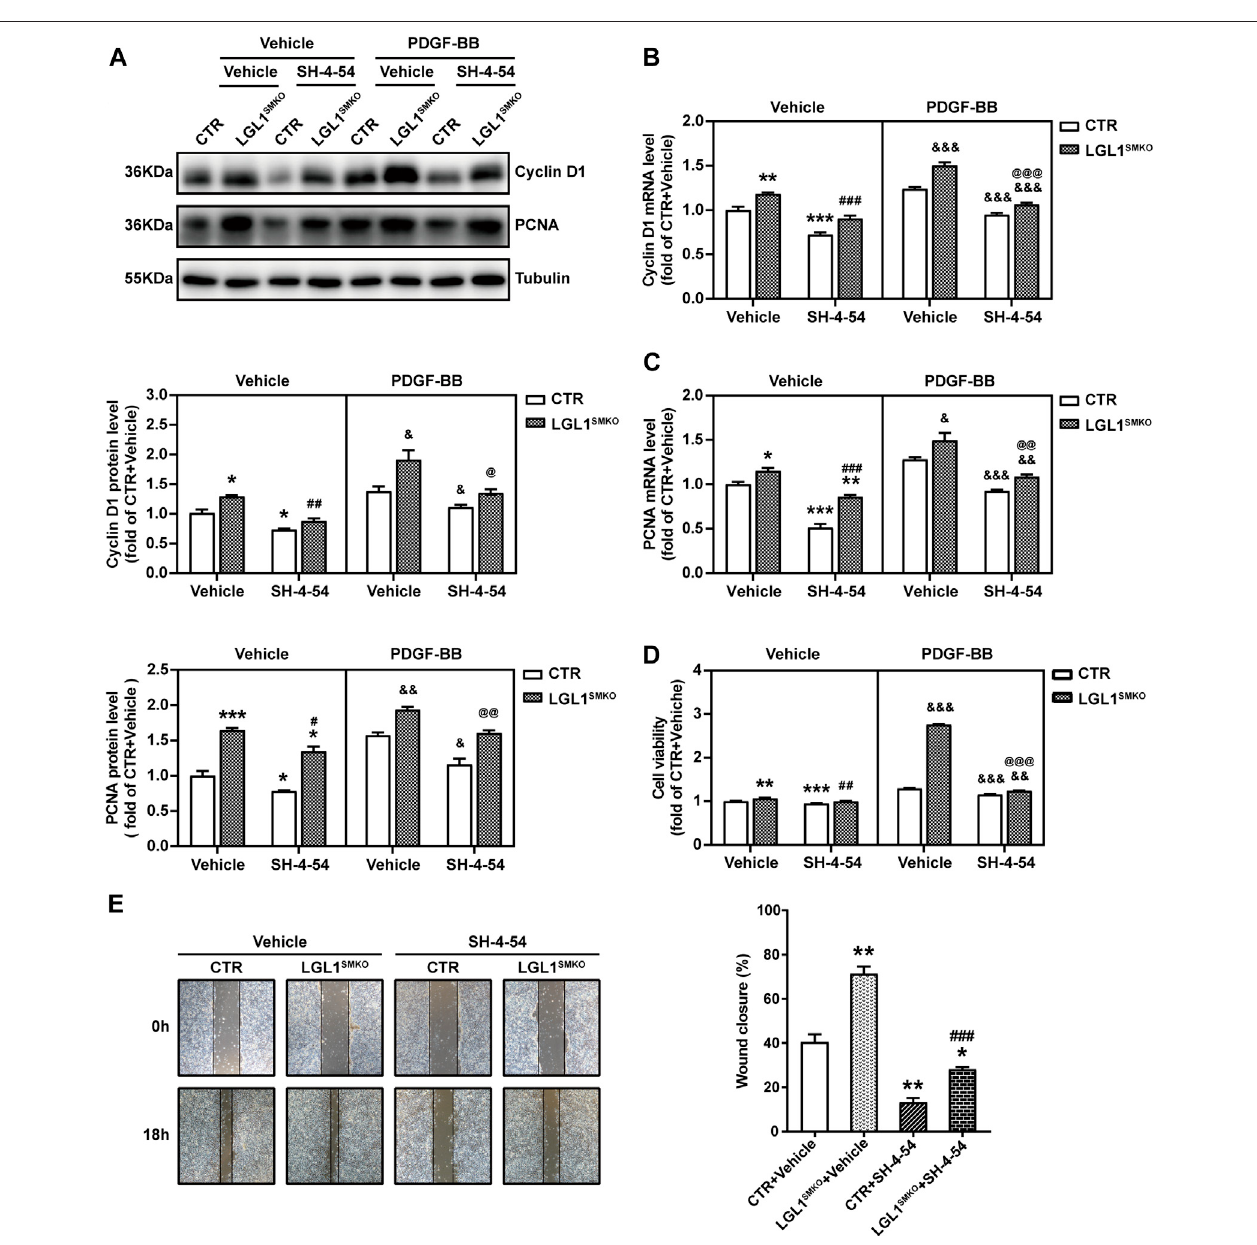
FIGURE 5 | LGL1 inhibited the proliferation and migration of VSMCs via STAT3. (A) Primary VSMCs were cultured from control (CTR) and LGL1 SMKO mice, pretreatedwithorwithouttheSTAT3inhibitorSH-4-54at10 μ Mfor24 h,andstimulatedwithPDGF-BBfor48 h.ProteinlevelsofCyclinD1andPCNAweredetectedby westernblotanalysis( n =3). (B,C) mRNAlevelsofCyclinD1 (B) andPCNA (C) testedbyqRT-PCR( n =4). (D) CellproliferationmeasuredbyCCK-8assay( n =8). (E) Cell migration evaluated by the scratch wound healing assay ( n = 3). Scale bar: 200 μ m. * p < 0.05, ** p < 0.01, *** p < 0.001 vs. CTR + Vehicle. # p < 0.05, ## p <